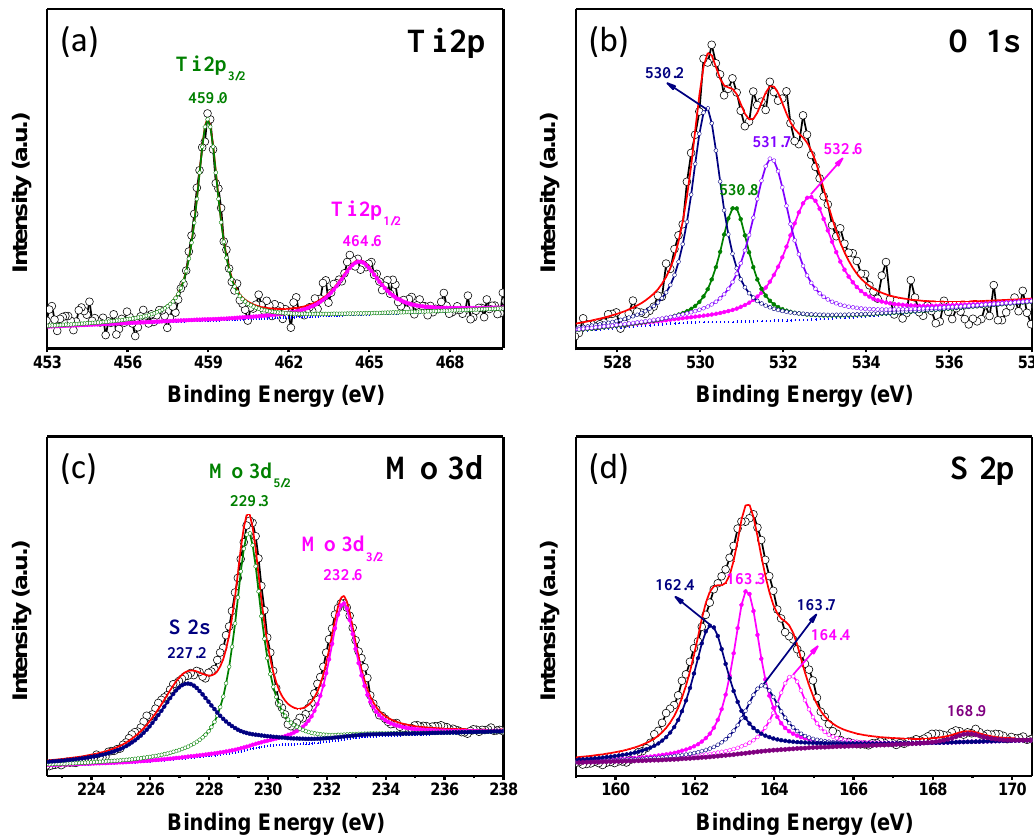
Figure 5. High-resolution XPS spectra of ( a ) Ti 2p, ( b ) O 1s, ( c ) Mo 3d and ( d ) S 2p in TiO 2 /PVDF@MoS 2 core-shell heterostructured fiber.